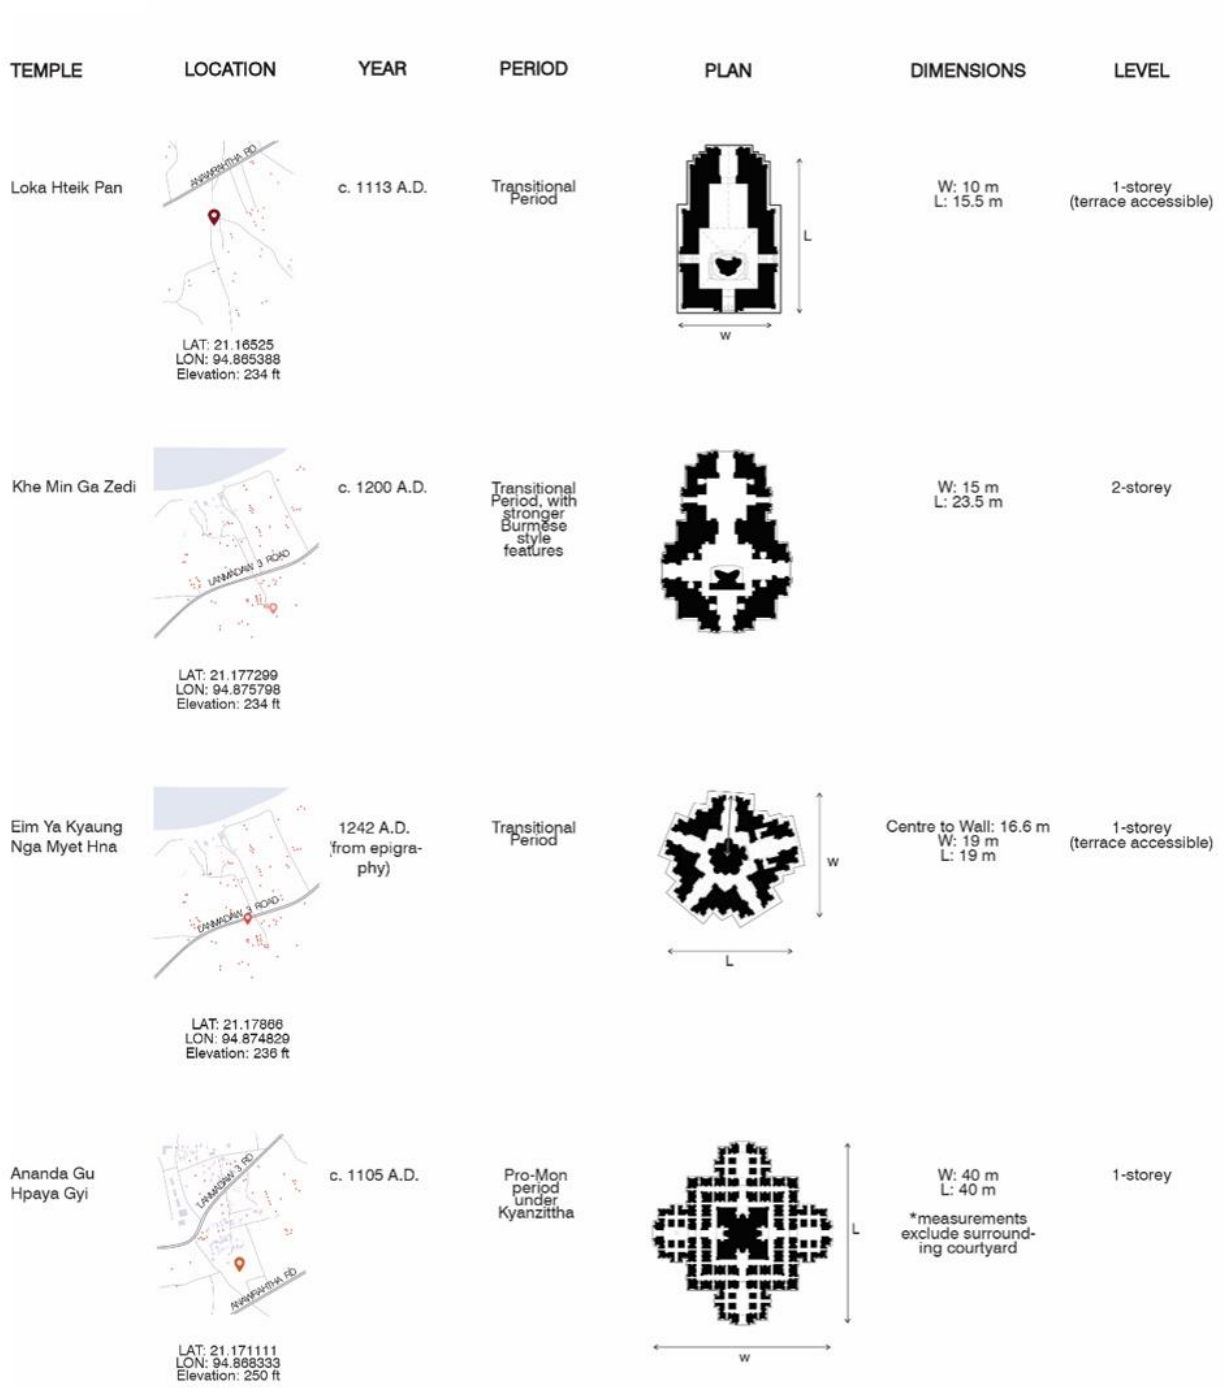
Figure 5. Digital Data archive of the four temples with contextual information. Compiled by Davide Mezzino and Lori